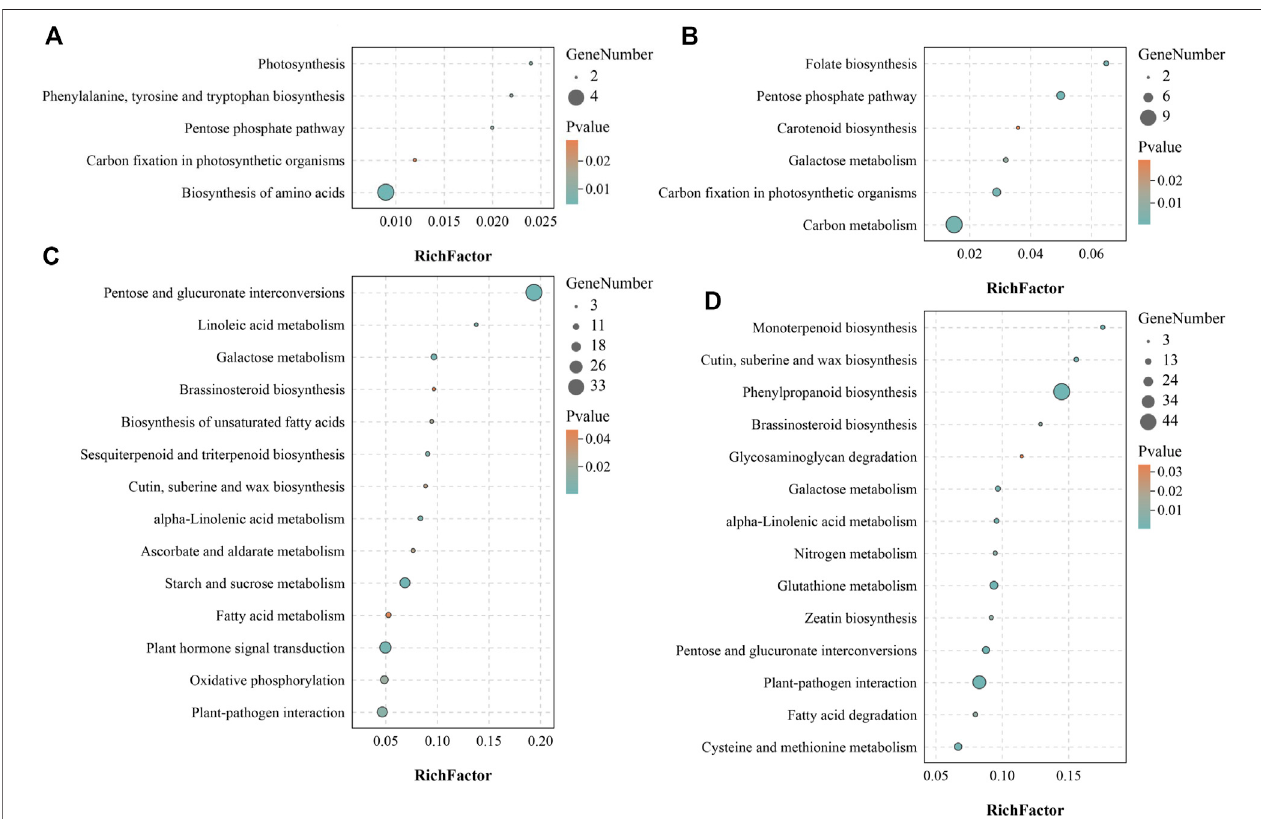
FIGURE 9 | KEGG enrichment analysis of four tissue-speci fi c modules. (A) KEGG enrichment analysis result of MEbisque4 module genes. (B) KEGG enrichment analysis result of MEred module genes. (C) KEGG enrichment analysis result of MEblue module genes. (D) KEGG enrichment analysis result of MEturquoise module